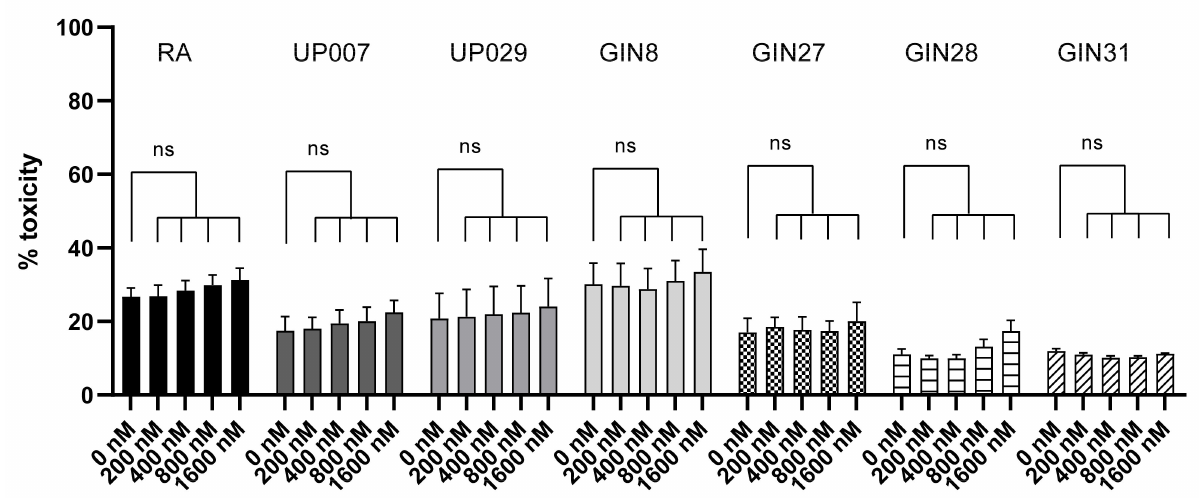
Figure 7. Control tests for TMRM dark toxicity. TMRM dark toxicity in the absence of illumination assessed using LDH assay. No statistically significant difference in toxicity between any of the 5 concentrations used in this experiment compared to the controls. N = 9: is the total number of datapoints for each condition from 3 independent experiments. ns—not significant.